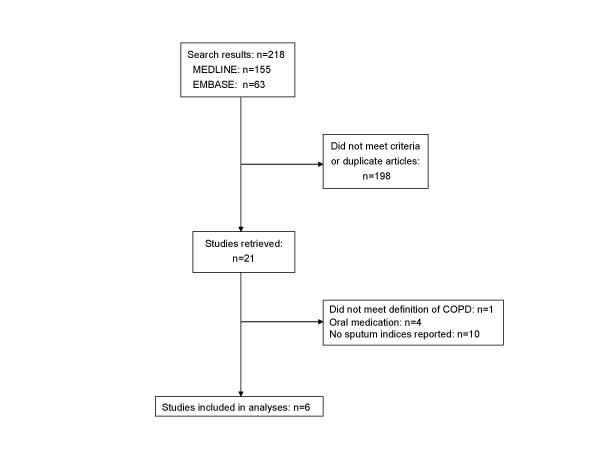
Study selection process